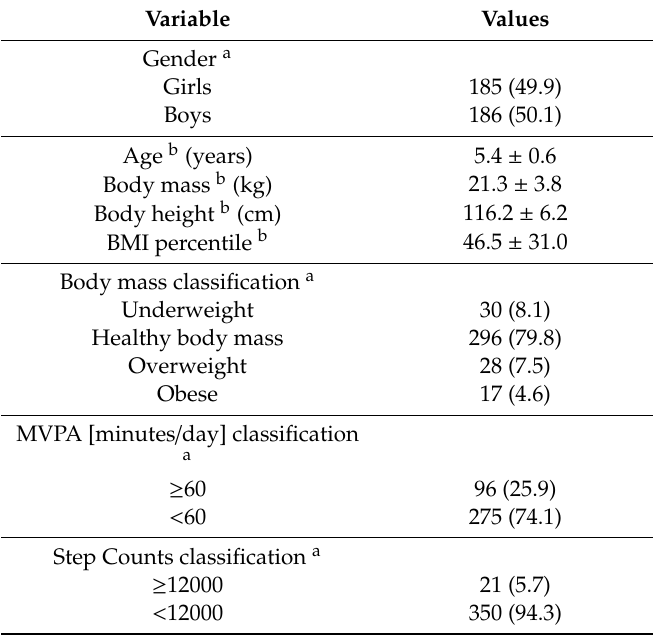
Table 1. Characteristics of children.